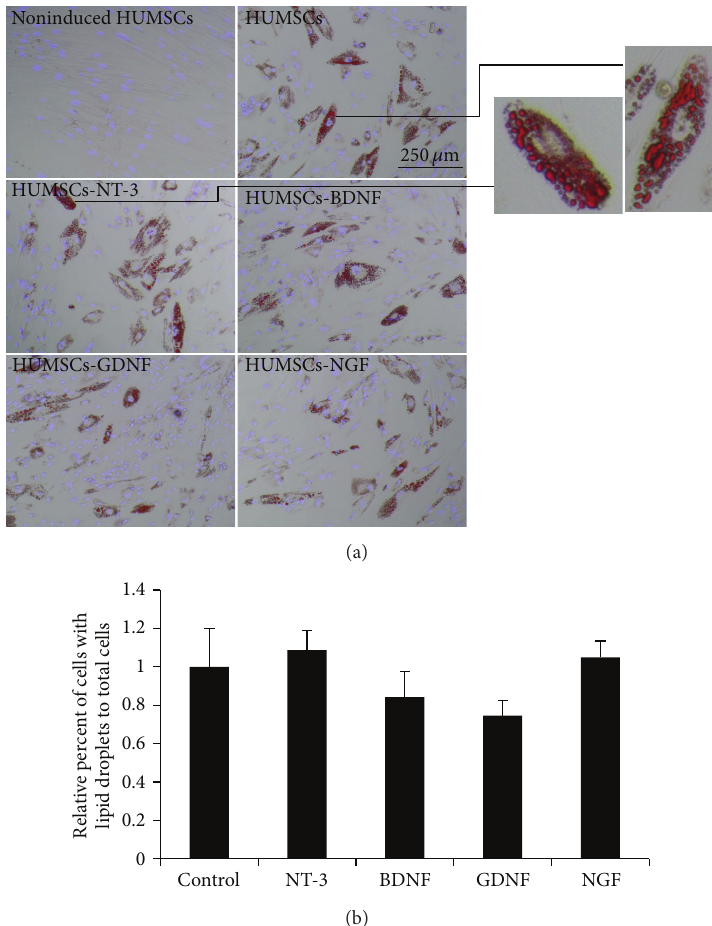
Figure 4: The effect of overexpression of NTFs on the adipogenic differentiation of HUMSCs. Transduced MSCs were cultured in adipogenic inductionmediumfor14days.(a)CellsstainedwithOilRedOandpicturedinrepresentativeareas.Scalebar=250 𝜇 m.(b)Relativepercentage of adipocytes to total cells stained with DAPI ( 𝑛 = 6